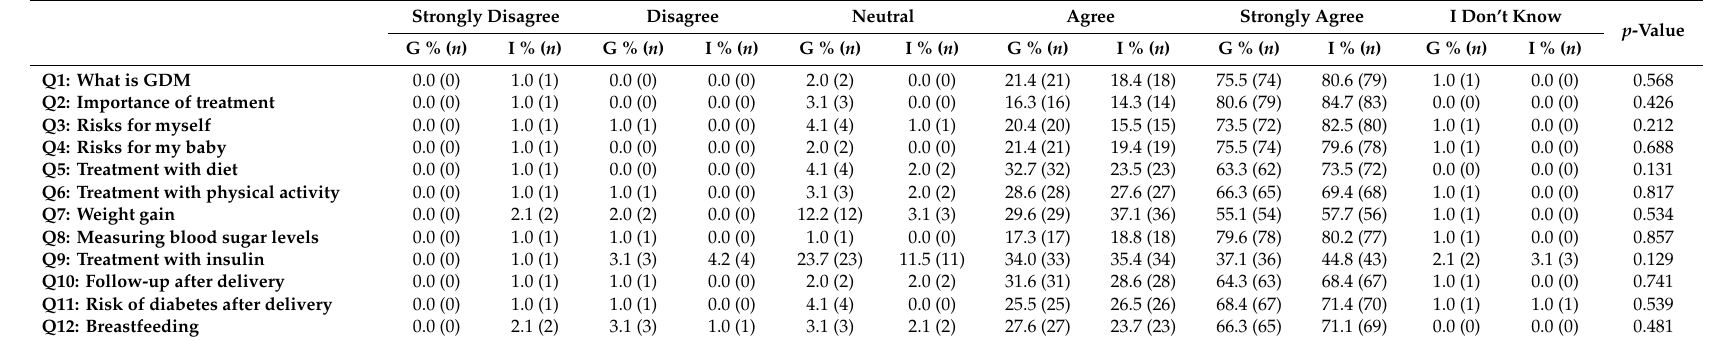
Table 6. Satisfaction rates with the given explanation on 12 items after the initial education session for women in group education compared to women in individual